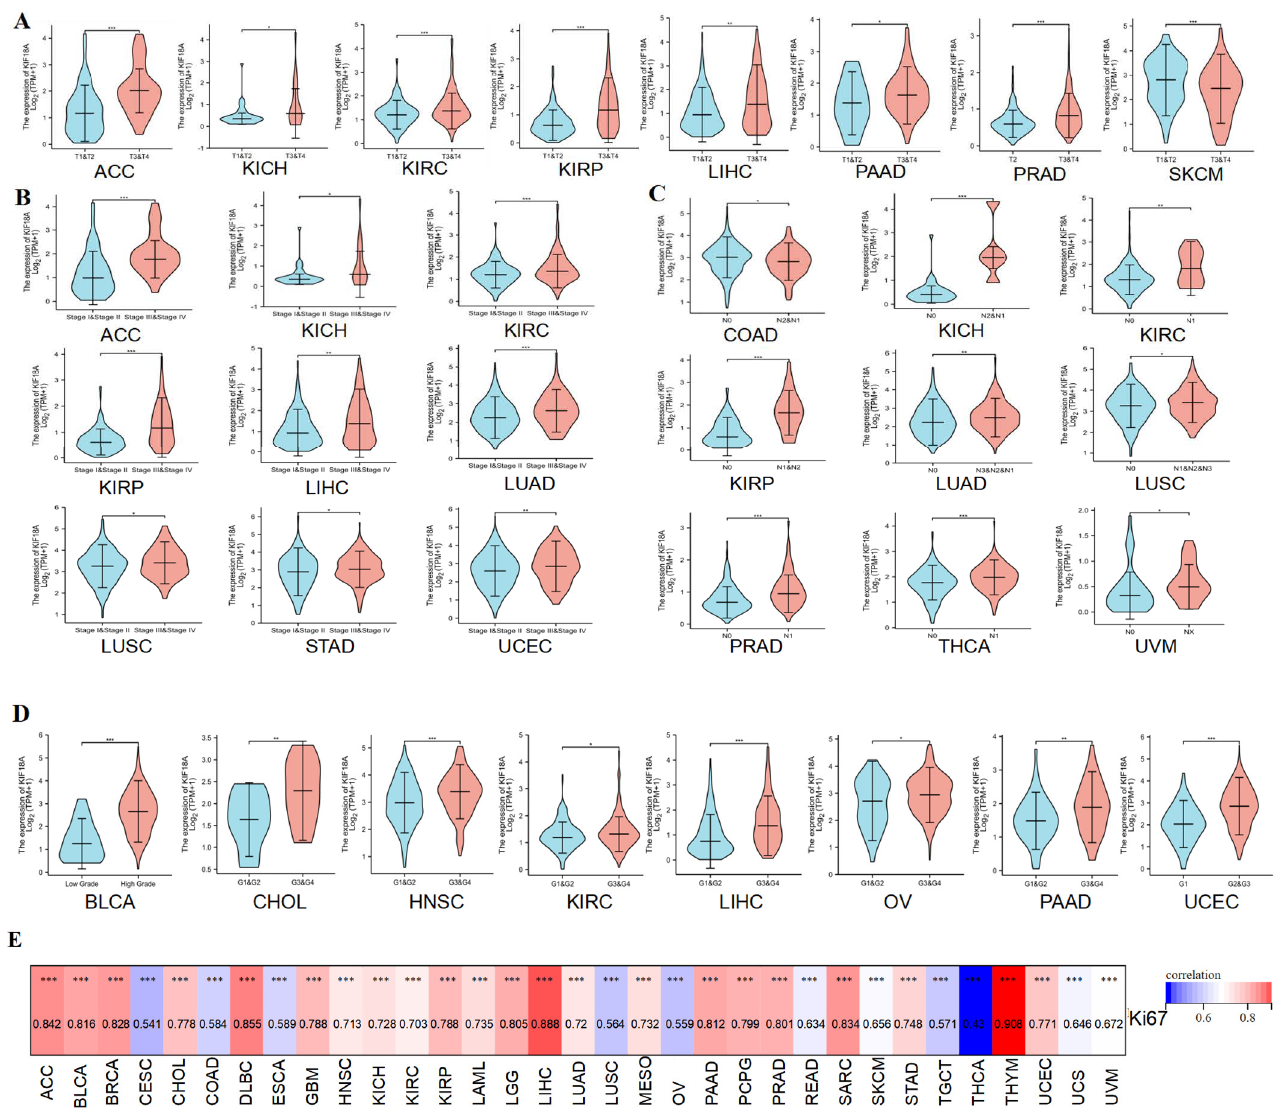
Figure 2. The relationship of KIF18A expression in cancers with clinical features. ( A ) The relationship of KIF18A expression to T stage in ACC, KICH, KIRC, KIRP, LIHC, PAAD, PRAD, and SKCM. ( B ) The relationship of KIF18A expression to the pathological stage in ACC, KICH, KIRC, KIRP, LIHC, LUAD, LUSC, STAD, and UCEC. ( C ) The relationship of KIF18A expression to N stage in COAD, KICH, KIRC, KIRP, LUAD, LUSC, PRAD, THCA, and UVM. ( D ) The relationship of KIF18A expression